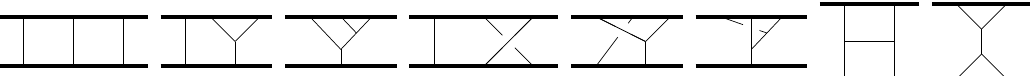
Figure 1. Cubic diagrams relevant for the potential-region amplitude in classical